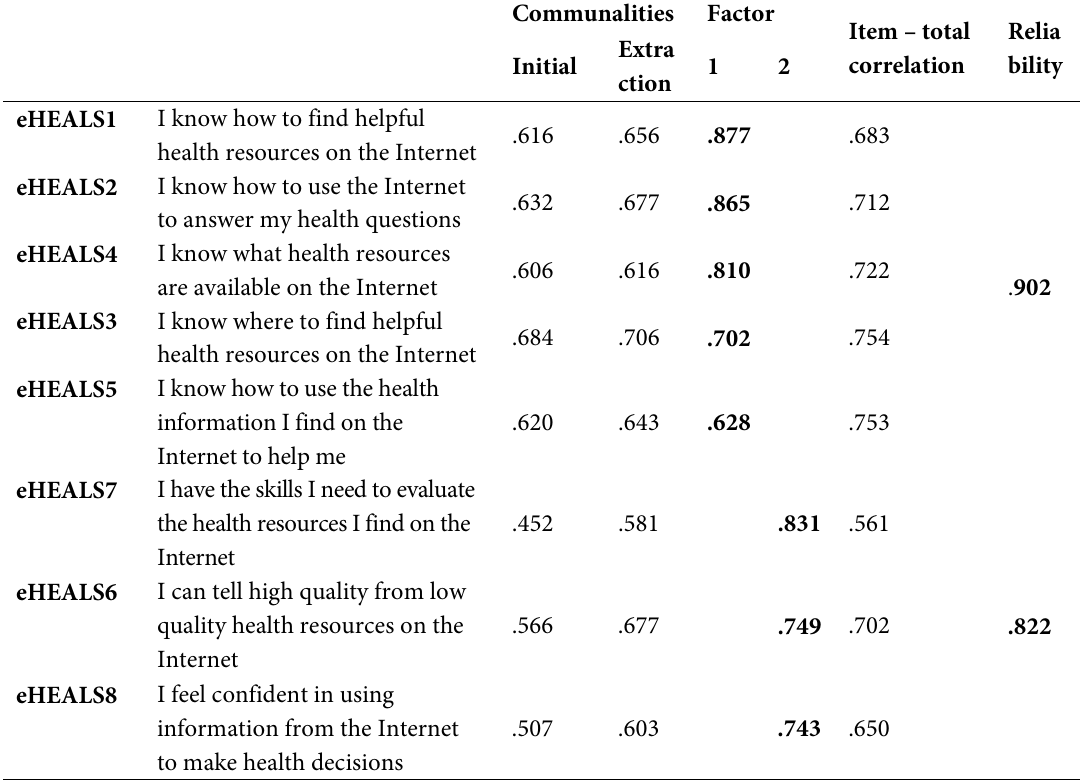
Table 1: Communalities and Pattern Matrix - eHealth Literacy